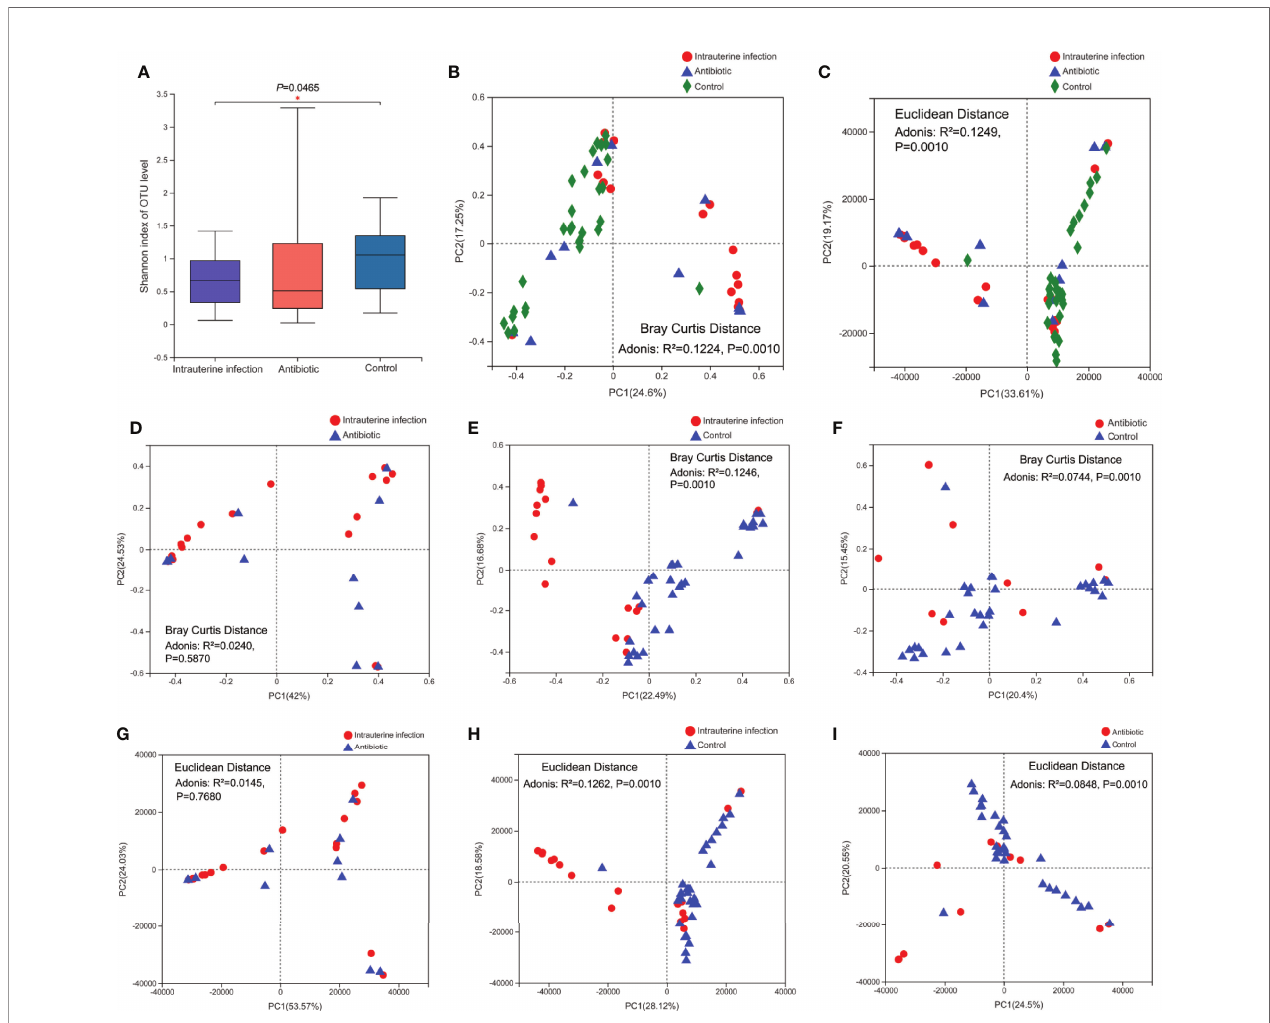
FIGURE 1 | (A) Gut microbiota a -diversity of three groups. PCoA of gut microbiota of three groups based on the Bray – Curtis distance (B) and Euclidean distance (C) . PCoA of the gut microbiota based on the Bray – Curtis distance between the intrauterine infection group and antibiotic group (D) , between the intrauterine infection group and control group (E) , and between the antibiotic group and control group (F) . PCoA of the gut microbiota based on the Euclidean distance between the intrauterine infection group and antibiotic group (G) , between the intrauterine infection group and control group (H) , and between the antibiotic group and control group (I) . “ * ” means P value smaller than